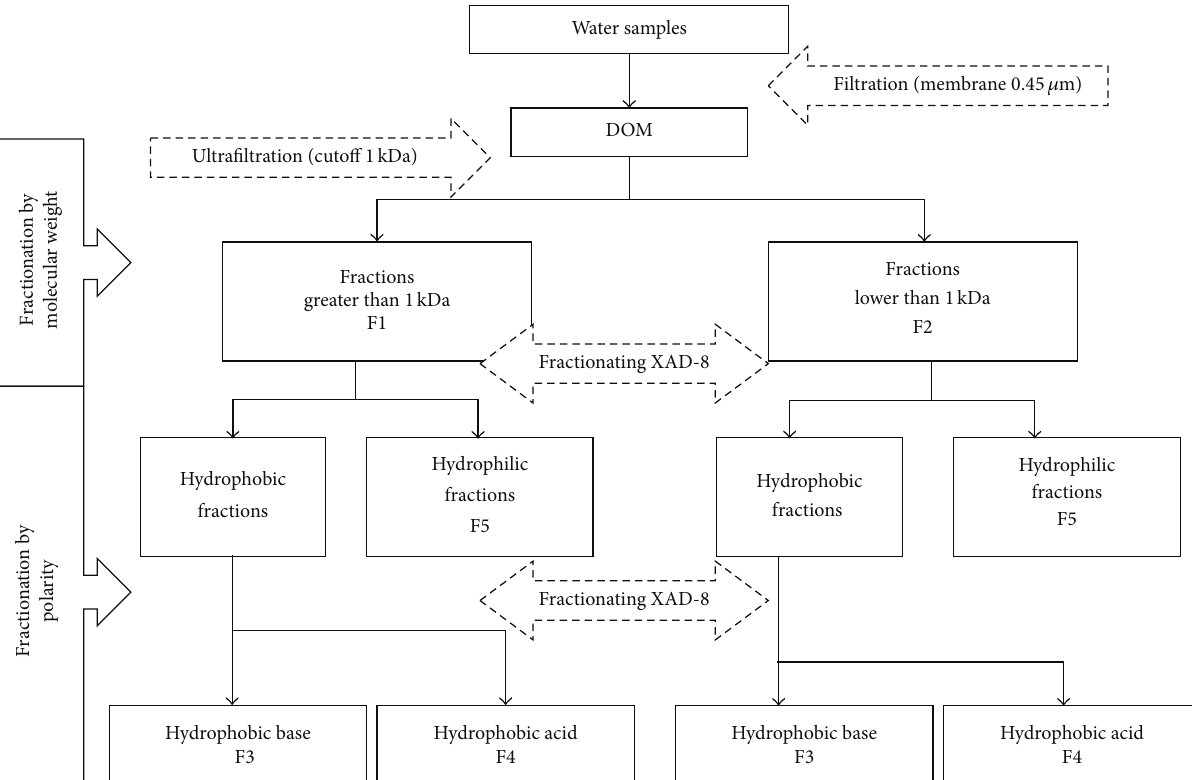
Figure 2: DOM fractionation scheme by molecular weight and